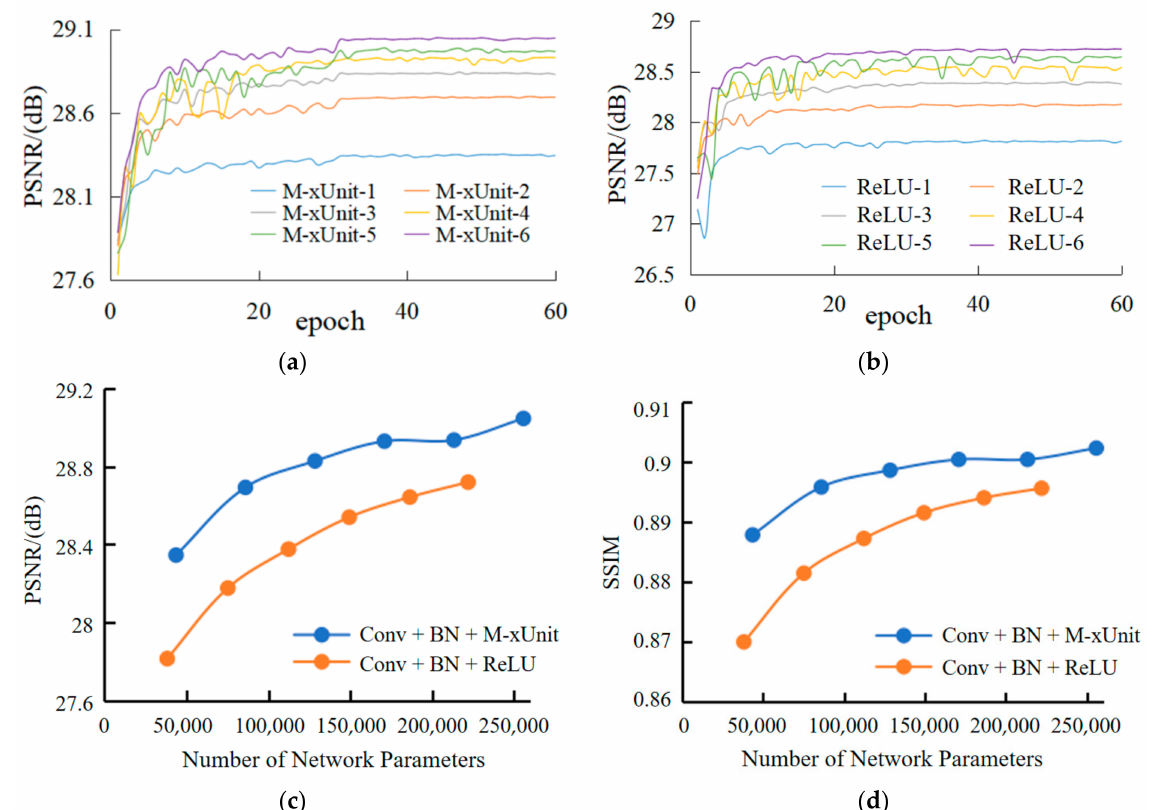
Figure 7. The performance analysis: ( a ) simulation curves of different “Conv + BN + M-xUnit” layers when L = 10, ( b ) simulation curves of different “Conv + BN + ReLU” layers when L = 10, ( c ) the comparison of PSNR between M-xUnit and ReLU, ( d ) the comparison of SSIM between M-xUnit and ReLU.